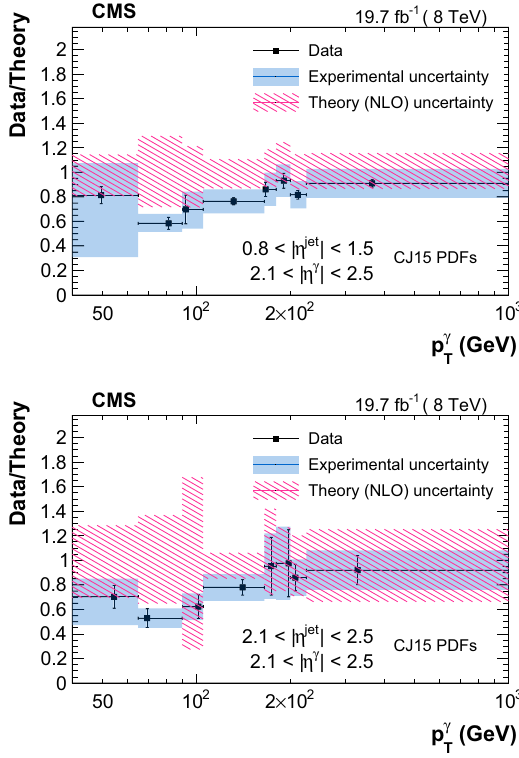
γ 2 . 1 < | η γ | < 2 . 5. Error bars on the data are statistical uncertainties, T and blue bands represent the systematic